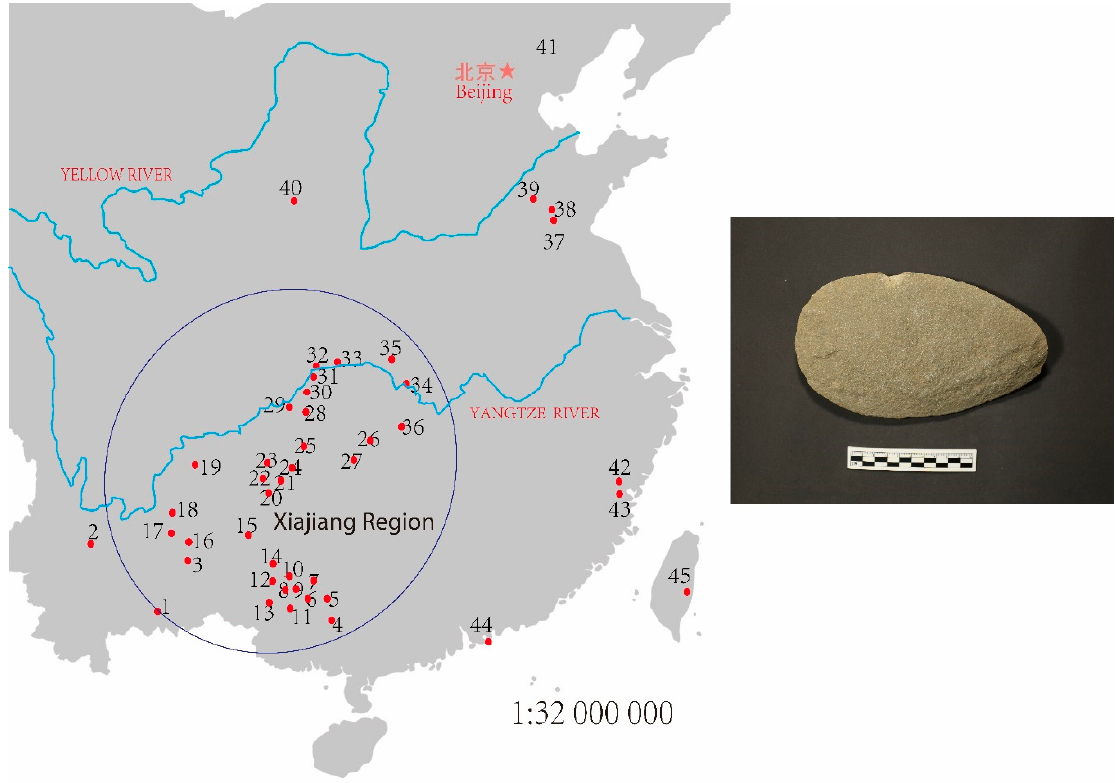
Figure 1. The distribution of Ridged-hammer Bipolar Flaking (RHBF) artifacts, China (1:32000000). 1.